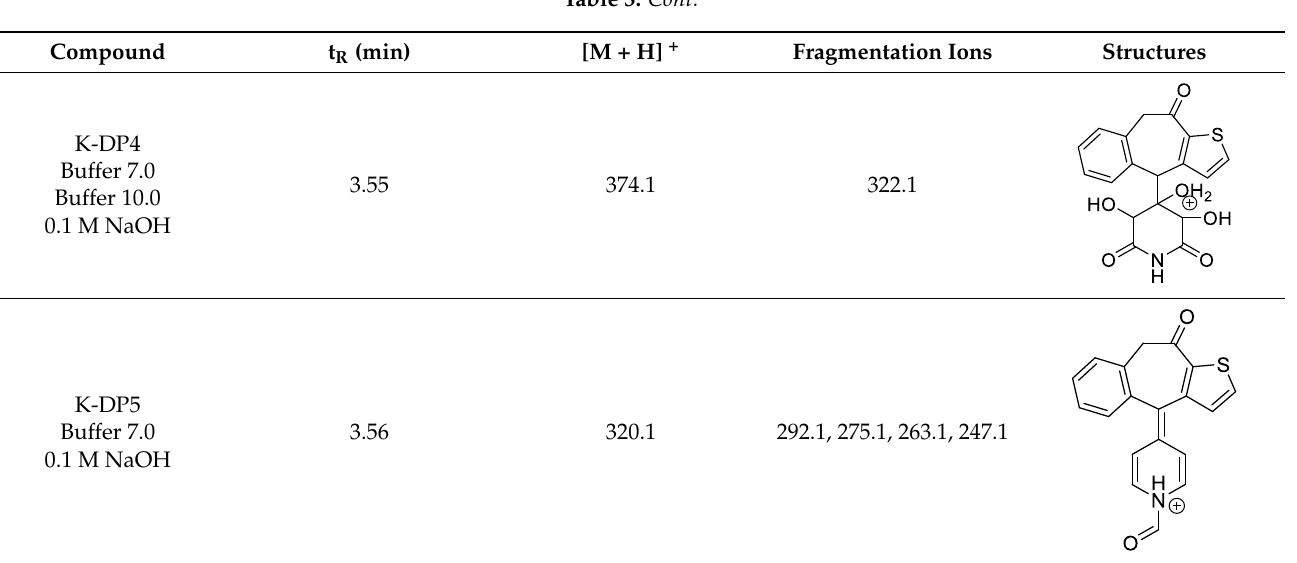
10 of 18 Table 3. MS/MS results for ketotifen (KETO) and its degradation products (K-DPs) at 70 °C. Compound